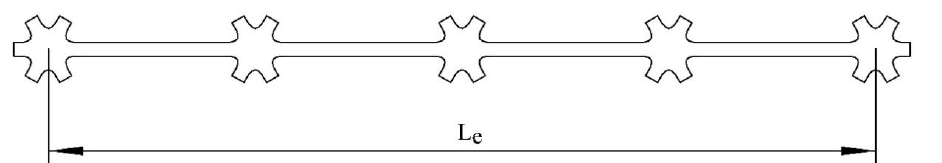
Figure 3. Sampling method for the tensile test at room